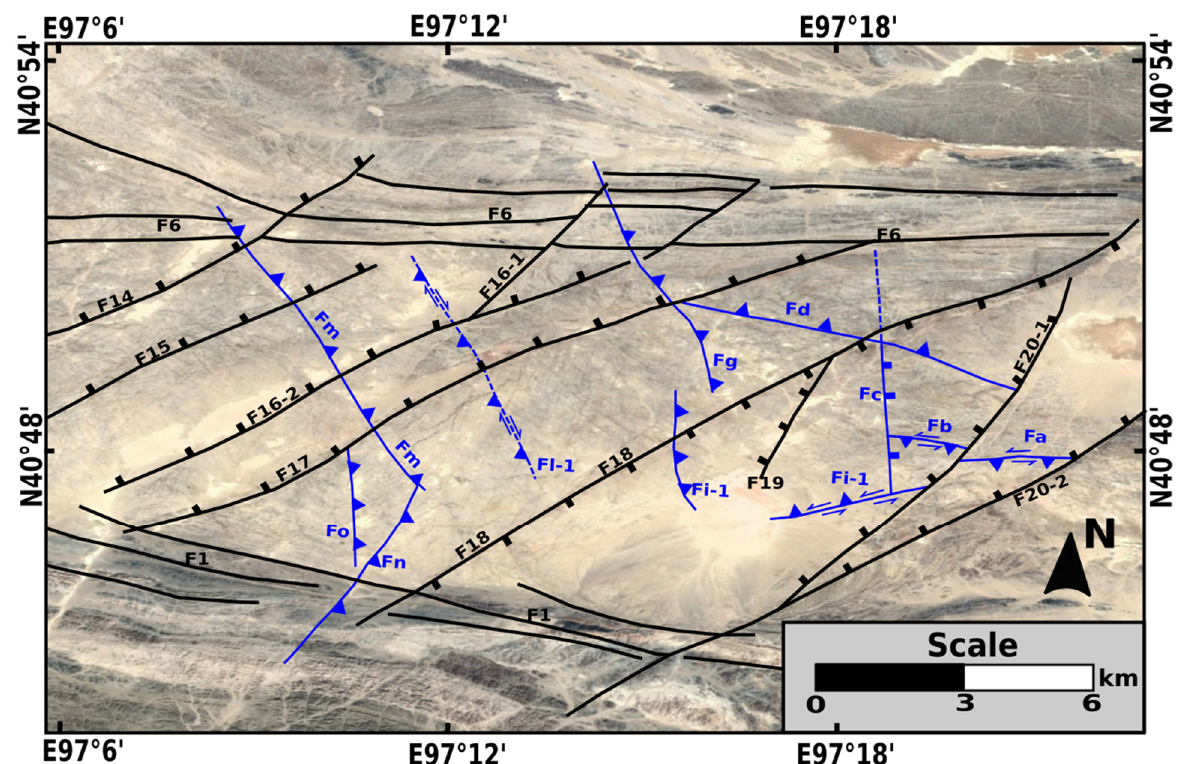
Figure 8. The distribution of faults in the Jiujing region in a Google Earth image, where faults found in the literature are highlighted by black lines and the newly identified faults are highlighted by blue lines.